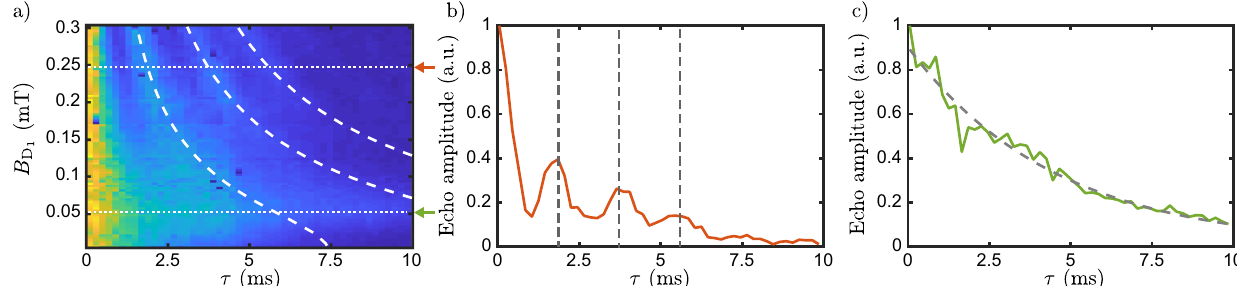
Fig. 3 Superhyper fi ne coupling close to the near-ZEFOZ line. Map of the echo decays as a function of time delay τ , for a range of fi elds along ¼ (cid:3) 220 μ T. The white dashed lines show multiples of the yttrium Larmor period, nT B D and for fi xed B D 1 2 ¼ (cid:3) 248 μ T shows clear ESEEM peaks at the multiples of T obtained at B D 1 discernible modulation. The magnetic fi elds for the two decays in b , c are indicated as horizontal dotted lines in a , and with circles in Fig.